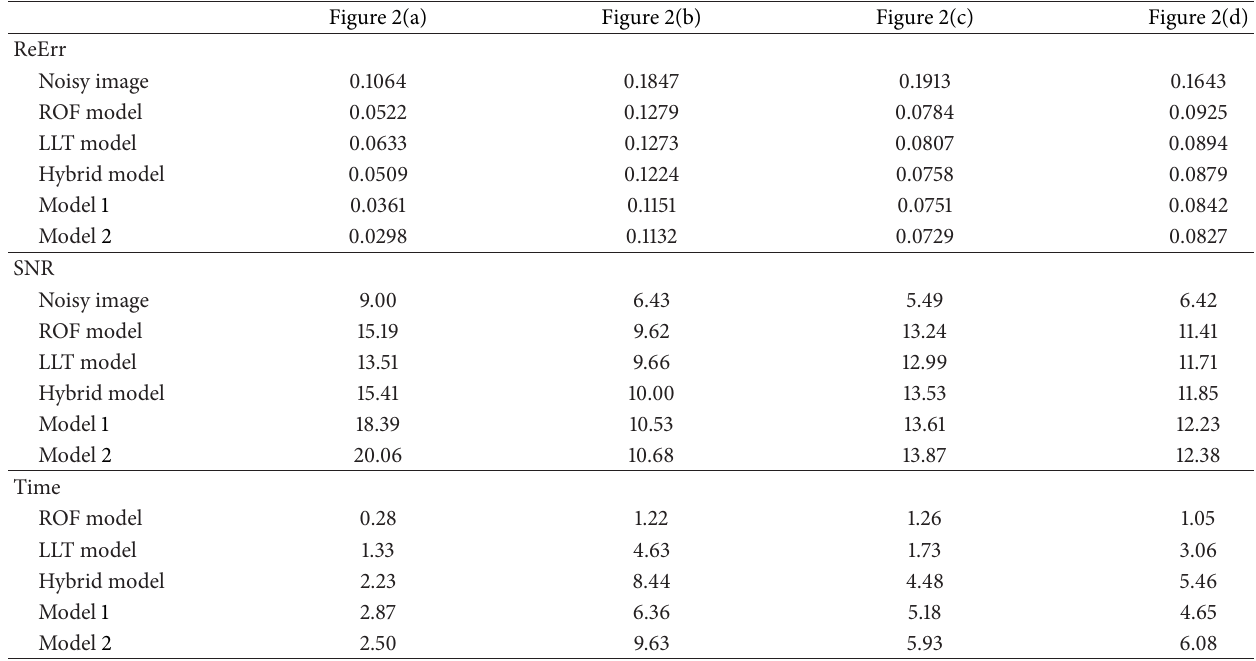
Table 1: Summarized results of the comparative